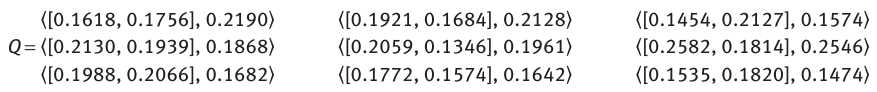
Table 4: The Weighted Normalized Value.